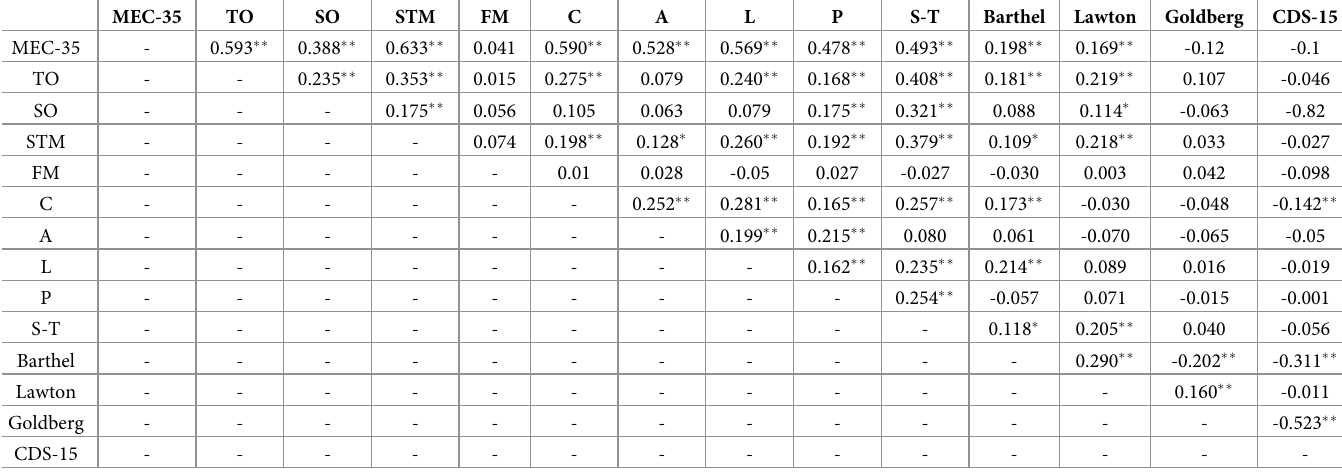
Table 4. Correlation coefficients between quantitative variables. The significant correlations are marked. MEC-35 TO